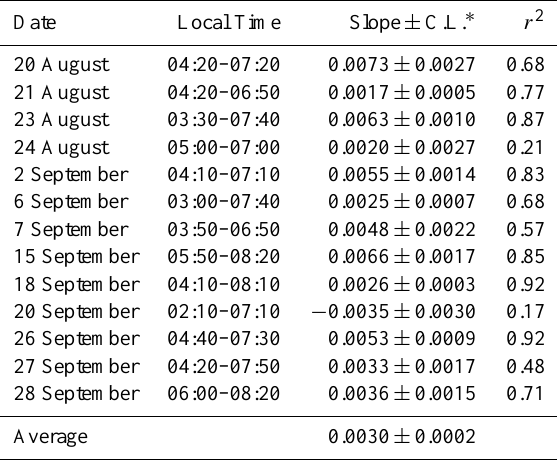
Table 2. Slopes derived from linear regressions of CH 2 O vs. CO for the selected morning vehicle traffic peak periods during 2006. Data were collected at the Moody Tower